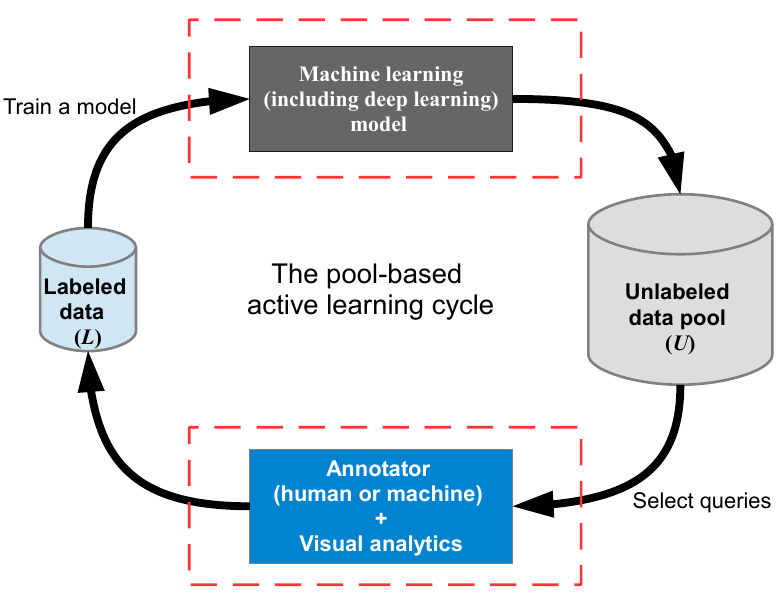
Figure 3. Review highlight for the pool-based active learning cycle (adapted based on